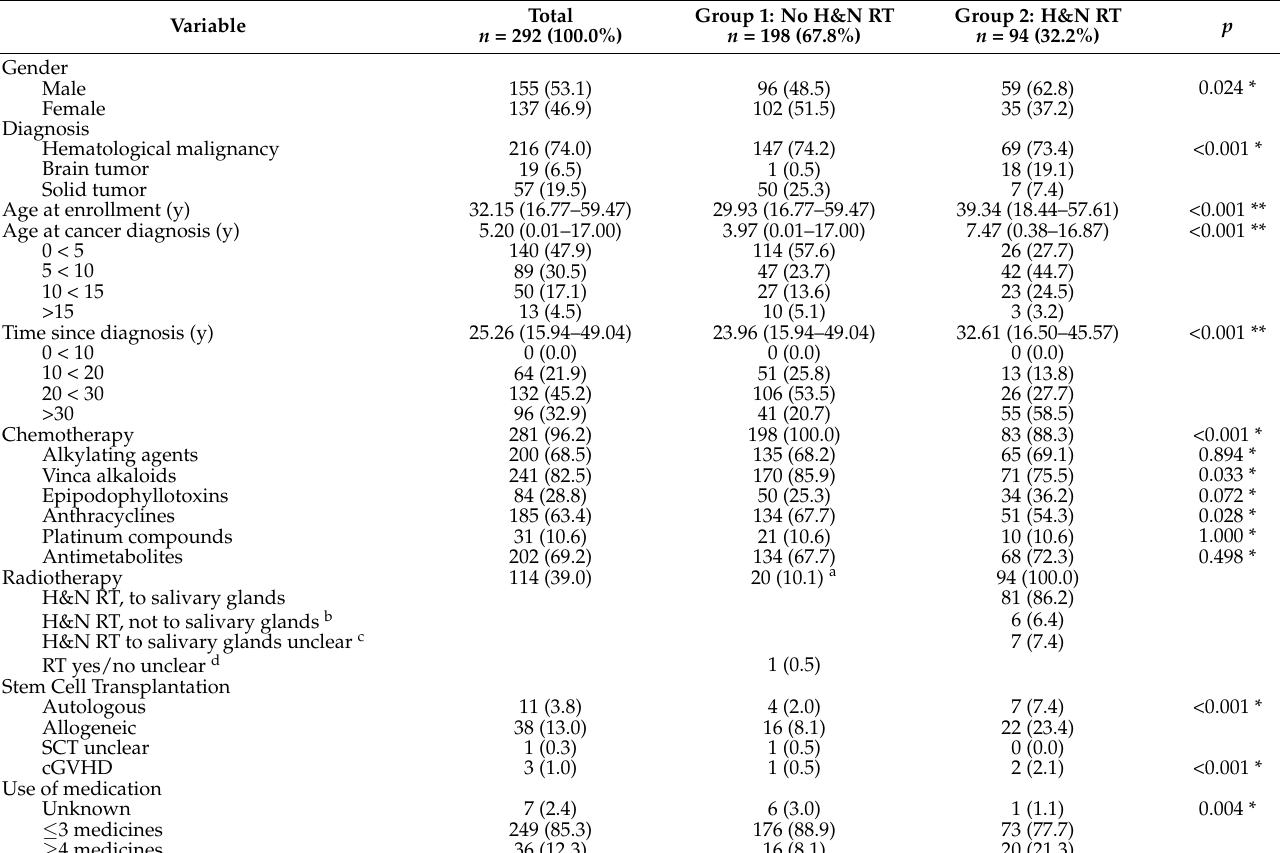
Table 1. Patient and treatment-related